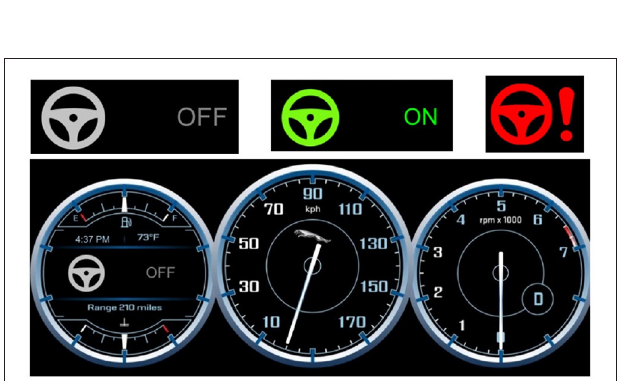
FIGURE 2 | Top: The icons showing the state of the automation. Gray icon: Autopilot OFF, Green icon: Autopilot ON, Red icon: Takeover Request (TOR). Bottom: The display of the dashboard, showing the state of automation mode, the speed and the number of engine’s revolutions per minute of the car.